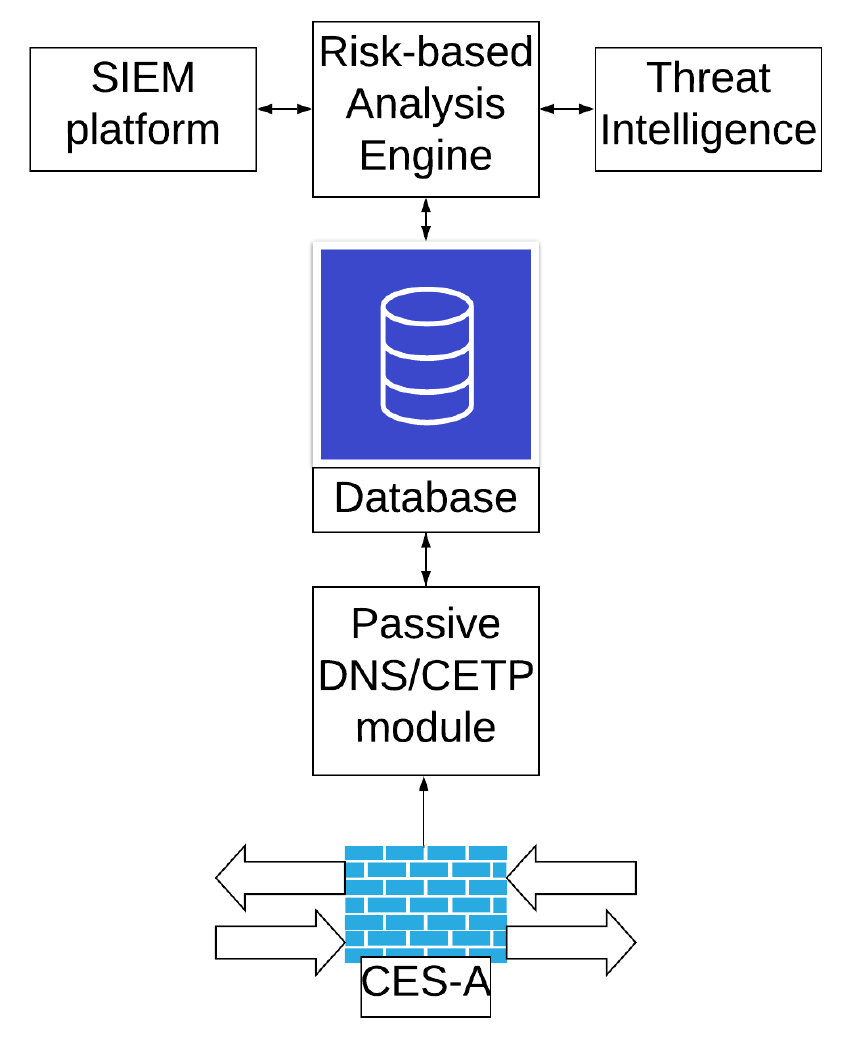
Figure 11. Model of Risk-based Analysis Engine with Passive